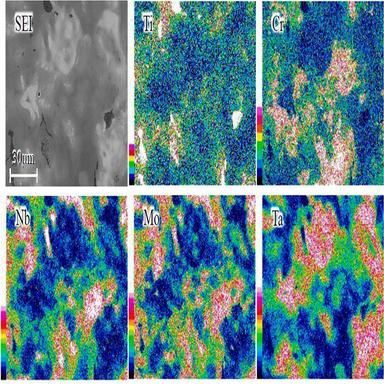
EDS maps of a sintered TiCrNbMoTa specimen (a) low magnification (b) high magnification.